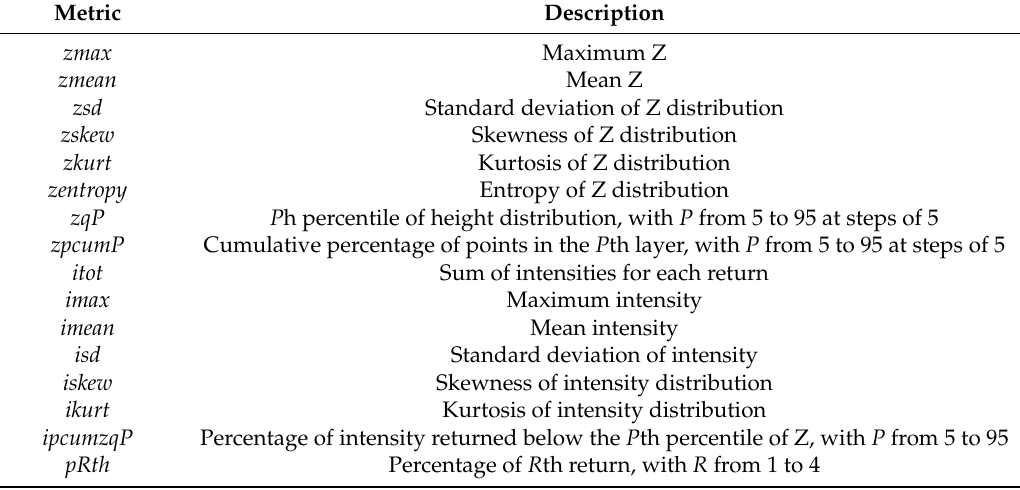
Table 3. Metrics extracted from the ALS